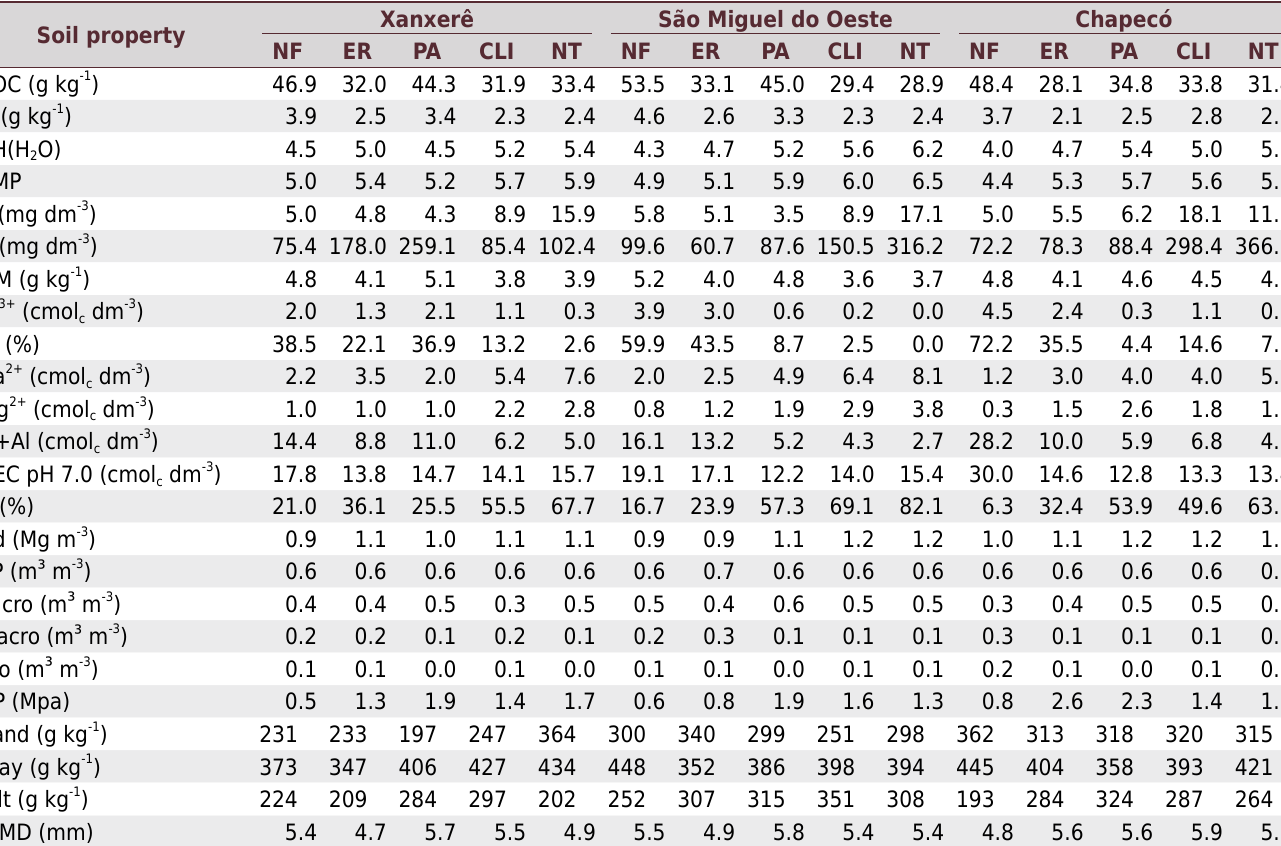
Table 2. Soil properties (0.00-0.20 m) under native forest (NF), eucalyptus reforestation (ER), pasture (PA), crop and livestock integration (CLI), and no-tillage (NT) in Xanxerê (Xan), São Miguel do Oeste (SMO), and Chapecó (Cha) Soil property